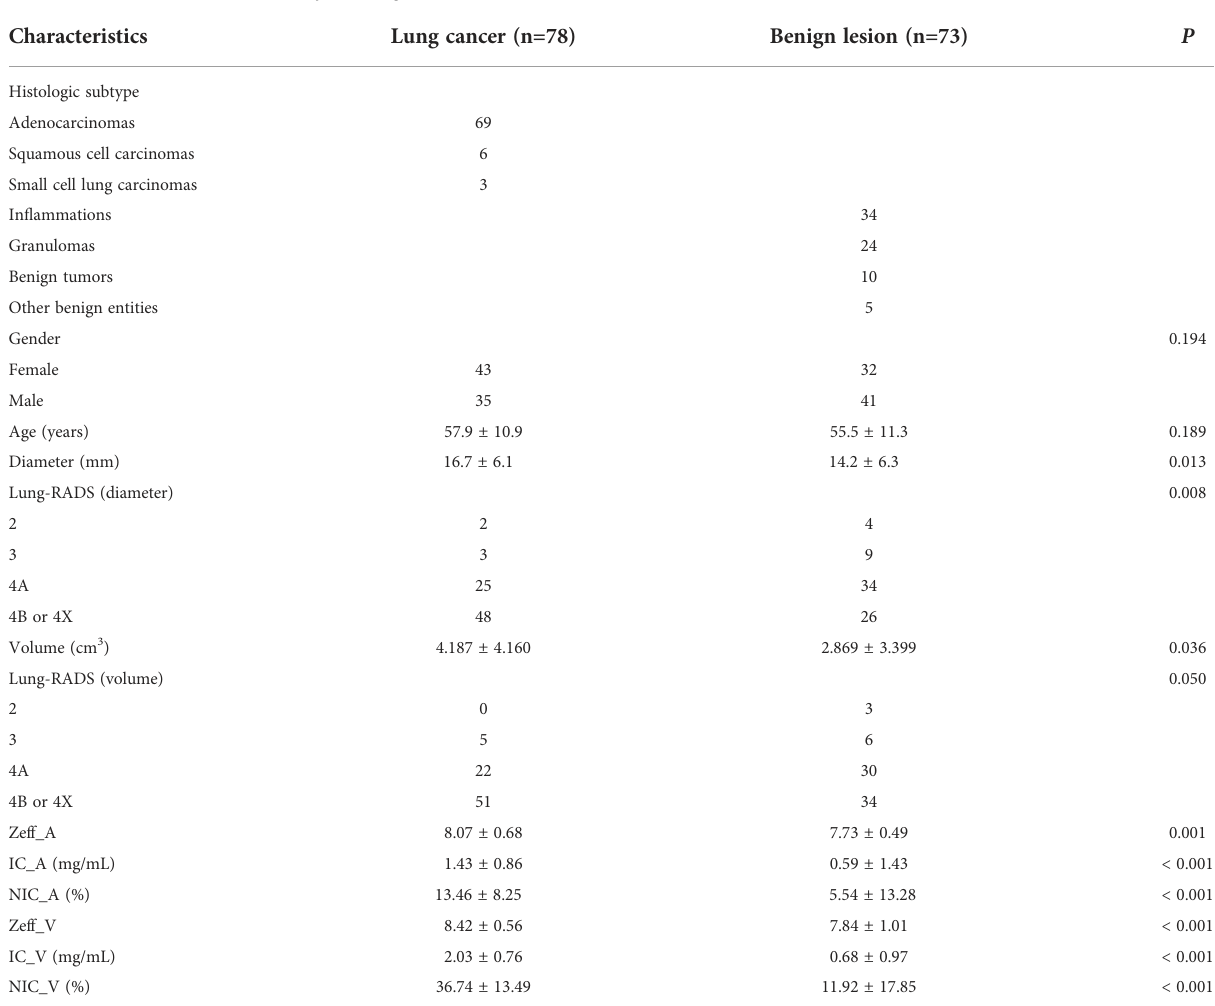
TABLE 1 The characteristics of solid pulmonary